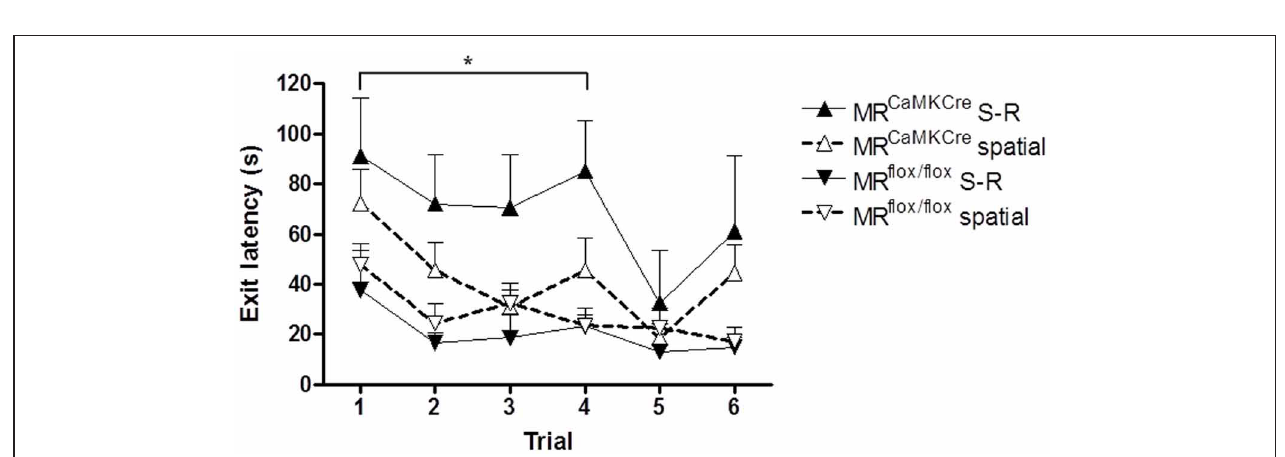
mice and black squares with a solid line represent control MR flox / flox mice. White circles with a dotted line are stressed MR CaMKCre mice and white squares with the dotted line represent stressed MR flox / flox mice. ∗ p < 0 . 05, compared to MR CaMKCre mice.